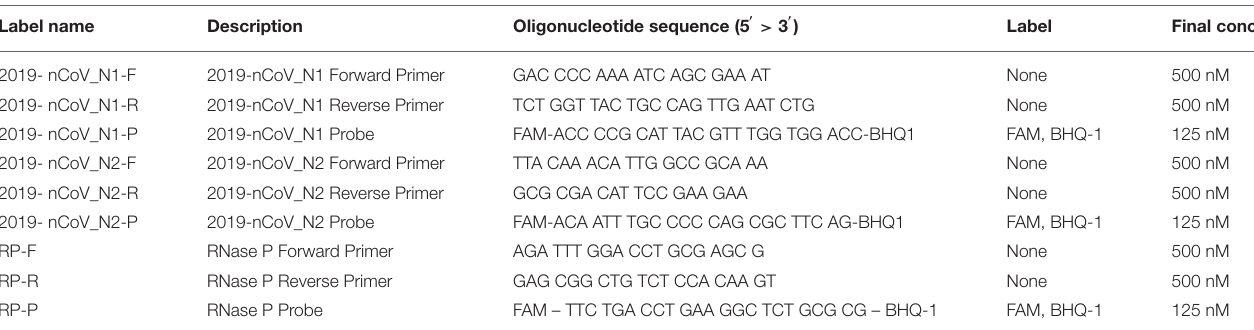
FIGURE 1 | Protocol for safe virus inactivation of RADT on-site. The experimental protocol was modified to facilitate the safe handling of real-field positive RADTs. SARS-CoV-2 positive RADTs are inoculated on-site with 700 µ L AVL provided in ready to use aliquots and transferred gently drop-by-drop. After an incubation of 10min, the RADT is transferred into a 50mL sample tube, sealed and maintained at 4 or 20 ◦ C, then delivered to the laboratory. TABLE 1 | Panel of primer and probes used for the RT-qPCR used in this